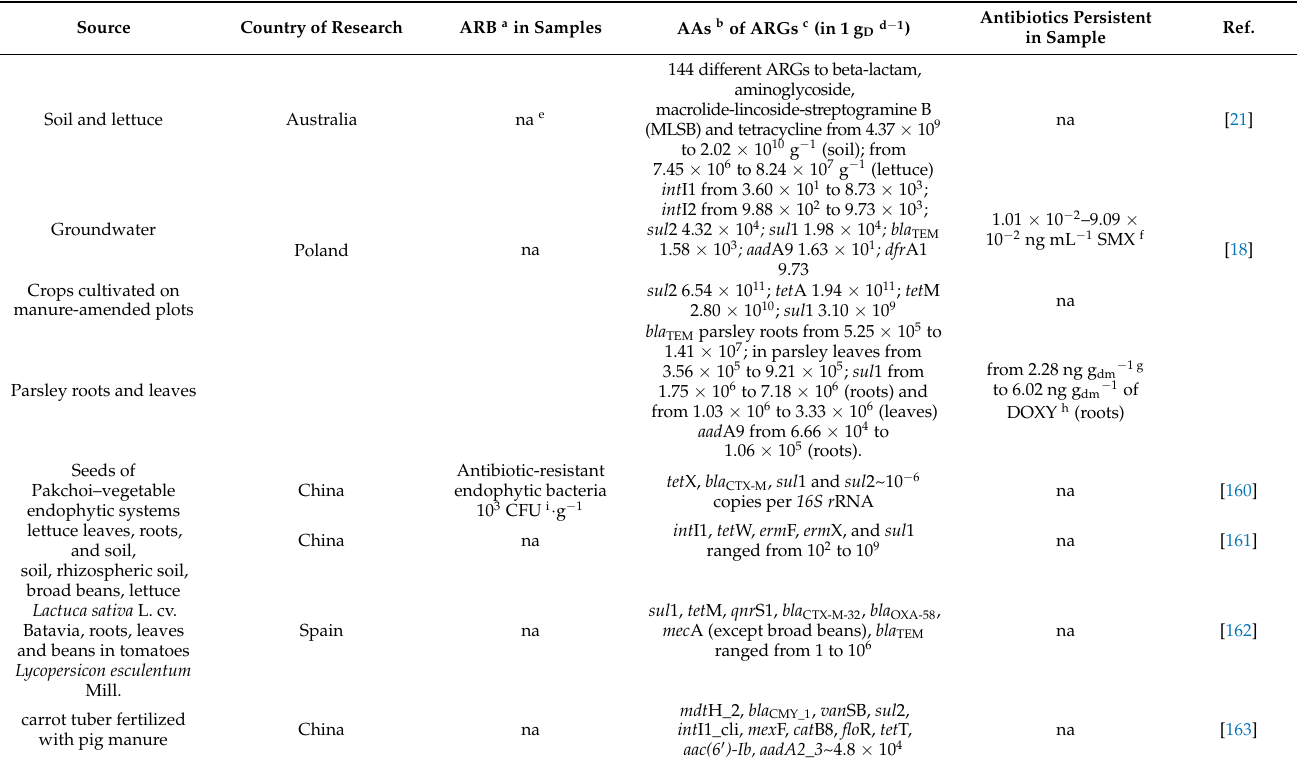
Table 9. Antimicrobials, ARB and ARGs detected in selected food samples of plant